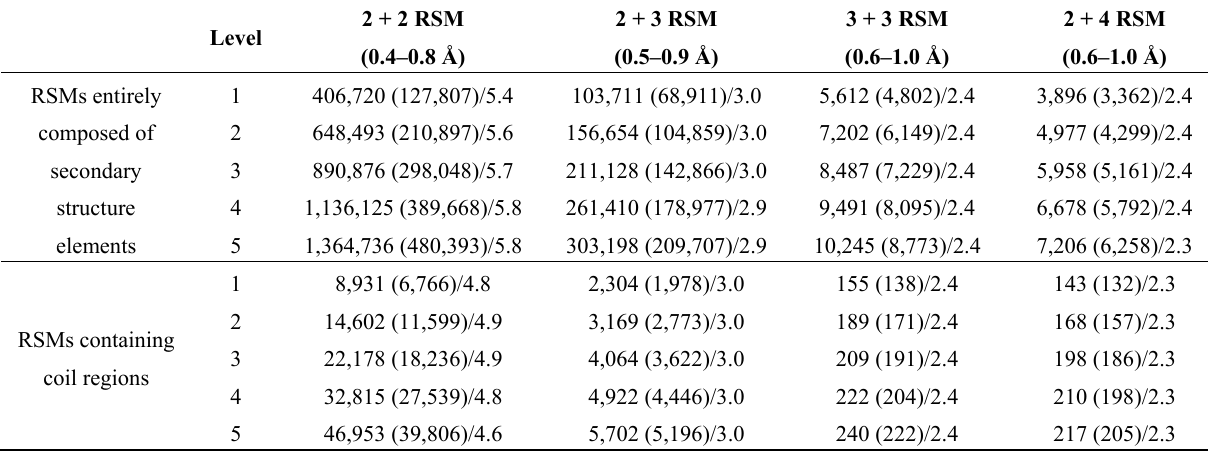
Table 1. Summary of recurrent structural motifs (RSMs) with backbone similarity requirements only. Summary of the number of recurrent non-contiguous structural motifs of different types and the following slash-symbols: the average degrees of recurrence, for different backbone root mean square distance (RMSD) cutoff levels (1 to 5) in increasing order from top to bottom with a step size between rows of 0.1 Å. The cutoff values are 0.4 to 0.8 Å for 2 + 2 RSMs, 0.5 to 0.9 Å for 2 + 3 RSMs and 0.6 to 1.0 Å for 3 + 3 and 2 + 4 RSMs. In parentheses: corresponding lower bounds on the number of distinct recurrent non-contiguous structural motifs (see end of Section 2.2 for